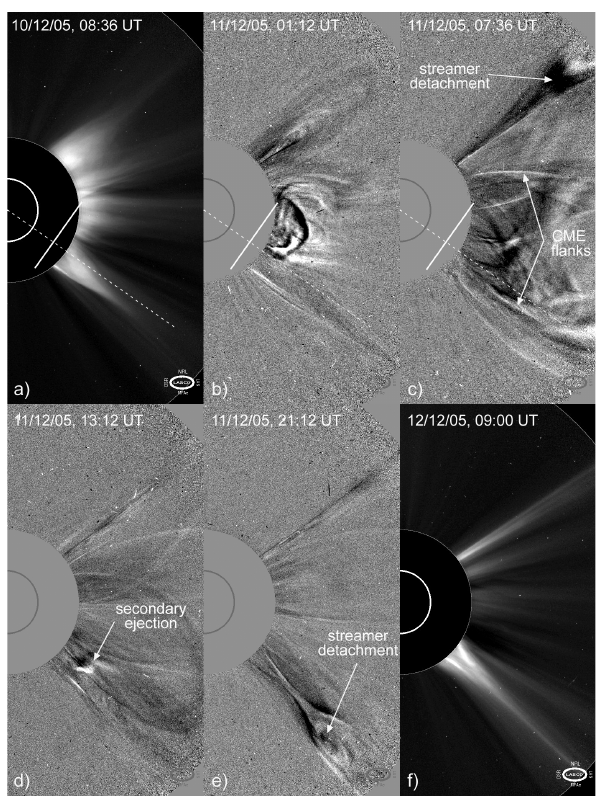
Fig. 2. The white light solar corona (west limb) as seen by the LASCO/C2 coronagraph in standard (panels a and f) and running difference (panels b–e) images; panel (a) : coronal configuration be- fore the event; panel (b) : CME propagation; panel (c) : northwest streamer detachment; panel (d) : secondary ejection after the CME; panel (e) : southwest streamer detachment; panel (f) : coronal con- figuration after the events; observation times are indicated in each panel. The solid white line corresponds to the position of the UVCS slit field of view, while the dashed line shows the radial towards the slit center at a latitude of 35 ◦ S; UVCS observations respectively started and ended rougthly at times corresponding to panels (a) and